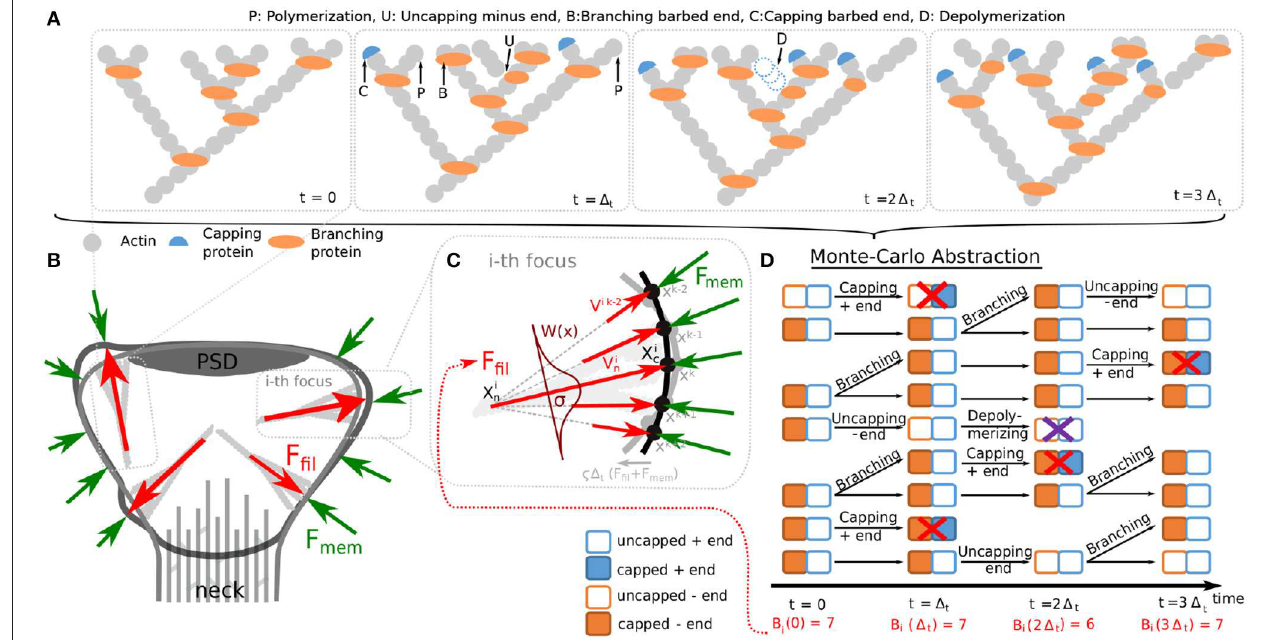
FIGURE 1 | Components of the proposed spine fluctuation model. (A) Schematic picture of actin filaments in a polymerization foci at successive time-points. Additional to polymerization of new actin monomers at the barbed ends, other events can occur in actin filaments, such as: branching the barbed ends by inserting branching protein Arp2/3, capping barbed ends with capping proteins, uncapping minus end and depolymerizing uncapped minus ends. These events are indicated by an arrow and the corresponding first letter (see glossary above the panels). (B) Our model for spine fluctuation assumes that the shape of the membrane